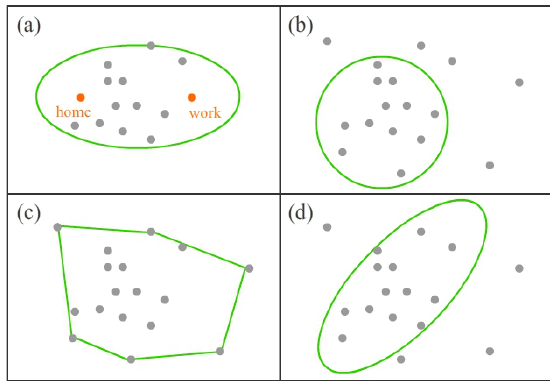
Figure. 3 Four ways to depict the activity space: (a) standard ellipse based on home and work place; (b) standard circle; (c) minimum convex polygon; (d) standard distance ellipse.